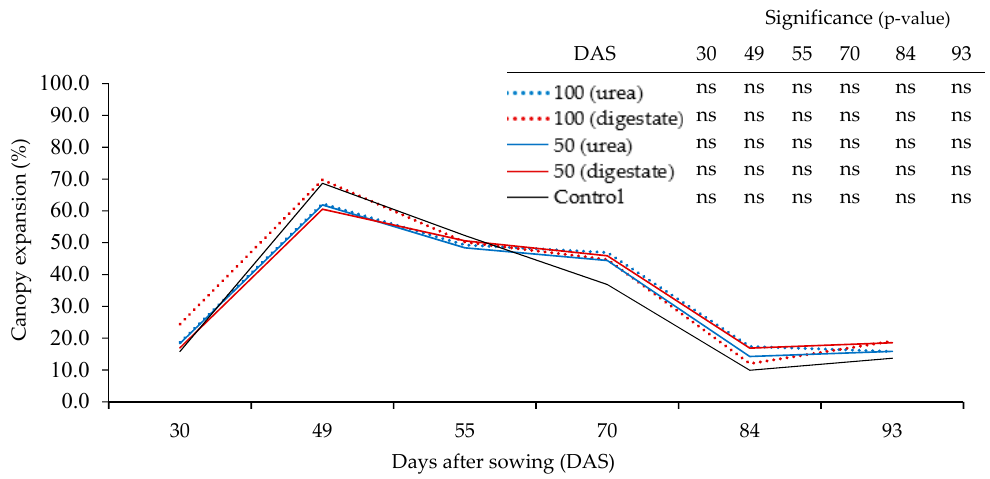
Legend: means that do not share a letter were significantly different (a, b, c) at the 5 % probability level using the Fisher test and ns (not significant) Figure 4. Canopy cover expansion (%) for different N fertilization treatments (100/50 kg N ha − 1 urea, 100/50 kg N ha − 1 digestate, and 0 kg N ha − 1 -control). A high coefficient of determination ( R 2 ) showed an agreement between POSs and crop development parameters (Figure 5 and Table 3). Significant differences were observed when examining the relationship between SPAD-502 and GreenSeeker ( R 2 = 0.81, p < 0.05 average of all values), and between SPAD-502 and Canopeo App. ( R 2 = 0.78, p < 0.05 average of all values). Canopeo App. ( R 2 = 0.52, p > 0.05 average of all values). The control showed the highest R 2 values between POSs (GreenSeeker vs. Canopeo App., SPAD-502 vs. Canopeo App. and SPAD-502 vs. GreenSeeker, with a p < 0.05, p < 0.01, and p < 0.01, respectively). Instead, the lowest R 2 values were observed under high N fertilization rates (both under 100-urea/digestate).